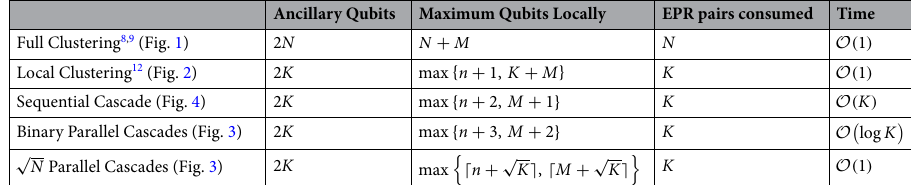
Table 2. Comparison of distribution protocols for a fully non-local N -controlled unitary.